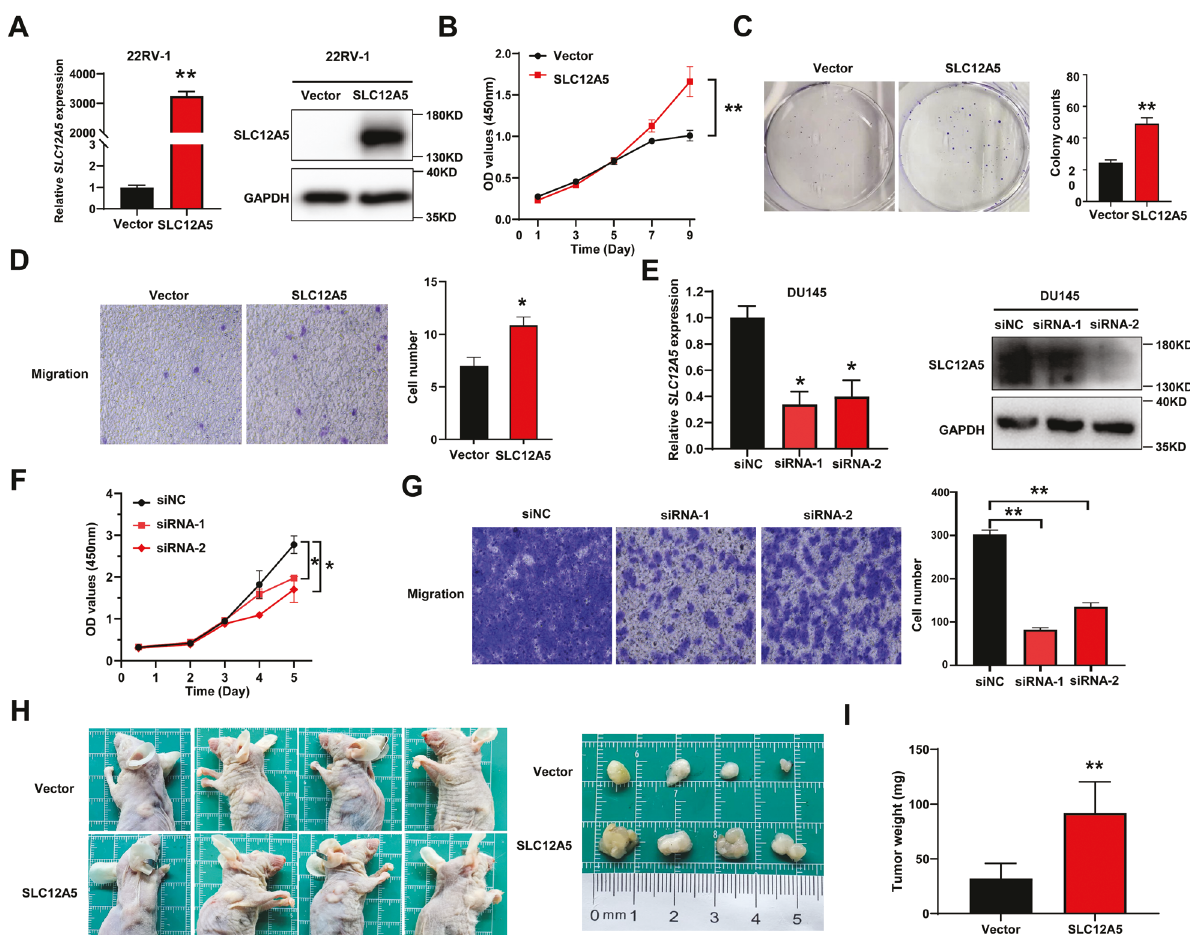
Fig. 2 Effects of SLC12A5 on prostate cancer cell proliferation and migration. A Exogenous overexpression of SLC12A5 was identi fi ed by qRT-PCR and western blot in 22RV-1 cells. B Cell proliferation curves were detected by CCK-8 assays after overexpression of SLC12A5 in 22RV-1 cells. C Colony formation of 22RV-1 cells after overexpression of SLC12A5 were detected. D Migration of 22RV-1 cells after overexpression of SLC12A5 were detected by transwell assays. Magni fi cation, ×200. E Knockdown of SLC12A5 by siRNAs were identi fi ed by qRT-PCR and western blot in DU145 cells. F Cell proliferation curves were detected by CCK-8 assays after knockdown of SLC12A5 in DU145 cells. G Migration of DU145 cells after knockdown of SLC12A5 were detected by transwell assays. Magni fi cation, ×200. H Subcutaneous xenograft tumors were dissected and photographed. I Tumor weight from the SLC12A5 and vector control groups. * P < 0.05; ** P <